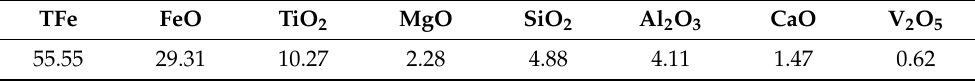
Table 1. The chemical compositions of vanadium-titanium magnetite (VTM) concentrate (wt%).